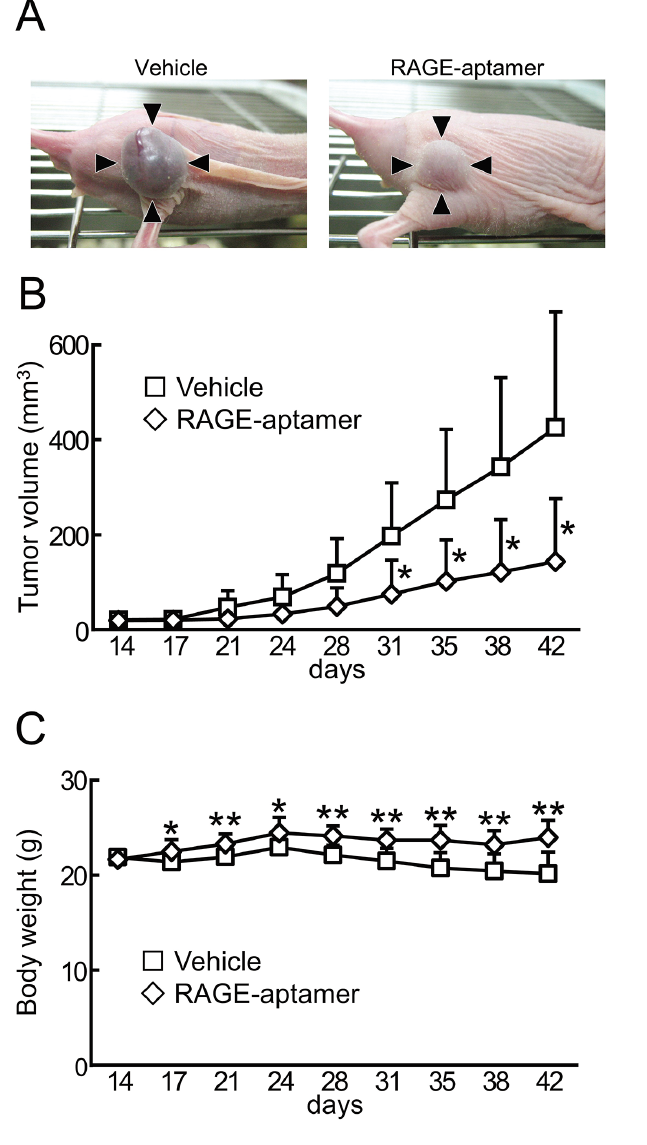
Figure 2. Effects of RAGE-aptamer on (A, B) tumor growth and (C) body weight in nude mice. Two million G361 cells were intradermally administered into the upper flank of 6-wk-old female athymic nude mice (N = 14). Mice received continuous intraperito- neal injection of RAGE-aptamer (N = 6) or vehicle (N = 8) by an osmotic minipump. Then tumor volume and body weight were measured twice a week. Panel A shows typical photographs of G361 tumors 42 d after each injection. Arrowheads indicate tumors. * and **, p < 0.05 and p < 0.01 compared with the values of vehicle-treated mice,